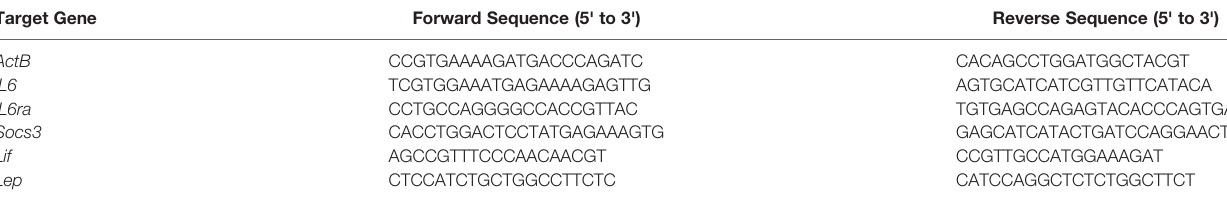
TABLE 3 | Oligonucleotide Sequences for Real-time PCR Analysis of Gene Expression Target